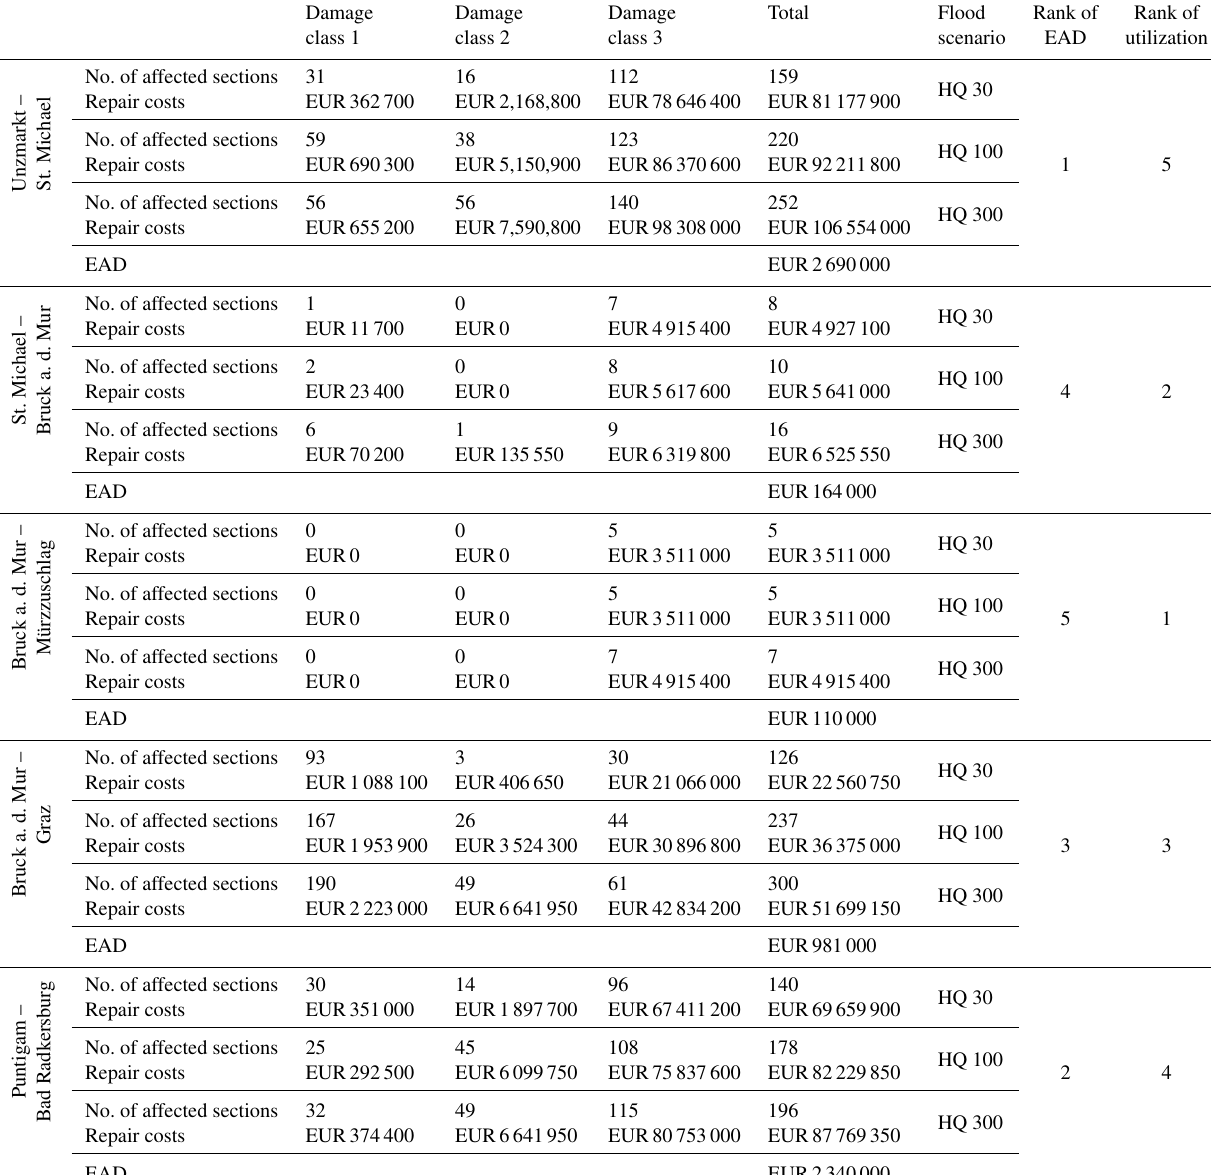
Table 2. Flood damage estimation on the level of selected operational sections. The table furthermore provides the individual rankings according to the EAD (expected annual damage) as well as the track utilization figure of